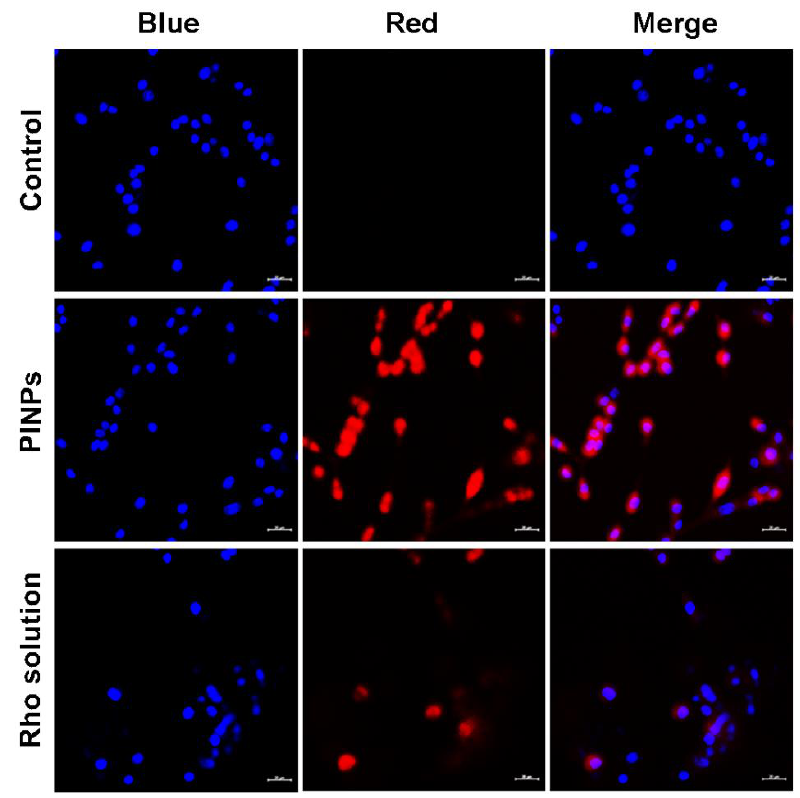
Figure 4. Confocal micrographs depicting cellular internalization of rhodamine 6G (Rho)-loaded PINPs after 2 h of co-incubation with C6 cells. Blue color: Hoechst (staining nucleus); Red color: Rho (staining cytoplasm). Scale bar: 20 µm.